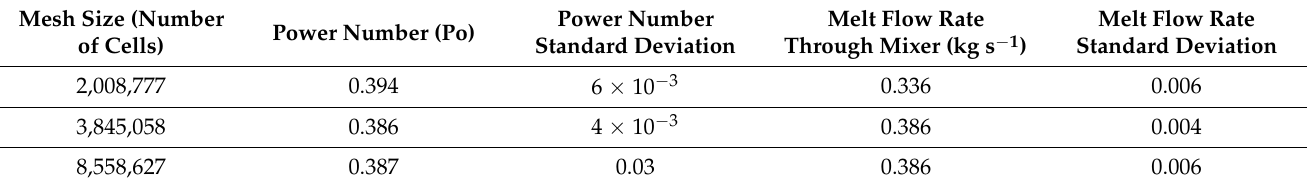
Table 2. Comparison of predicted power number and volume flow rates with rotor A for three different grid sizes computed in inline mode with rotor speed 1000 RPM.